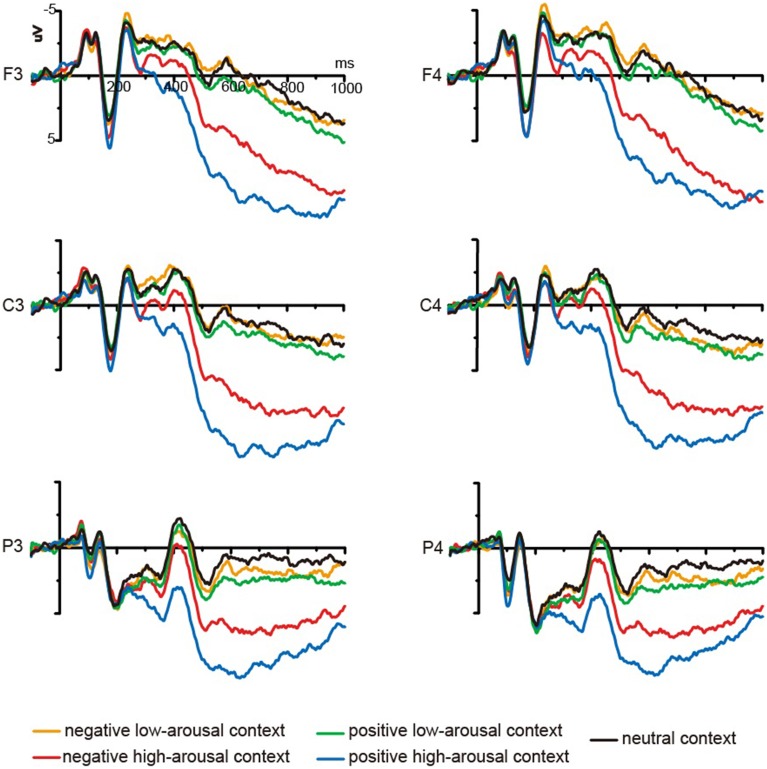
Grand mean ERPs from F3, F4, C3, C4, P3, and P4 to words presented in five types of background pictures at encoding.